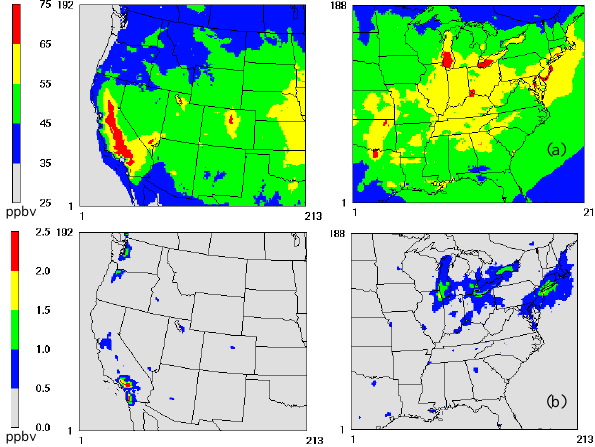
Fig. 5. (a) Monthly mean daily 8-h maximum O 3 with CB05-Base (b) absolute increases in mean daily 8-h maximum O 3 between CB05-TU and CB05-Base.